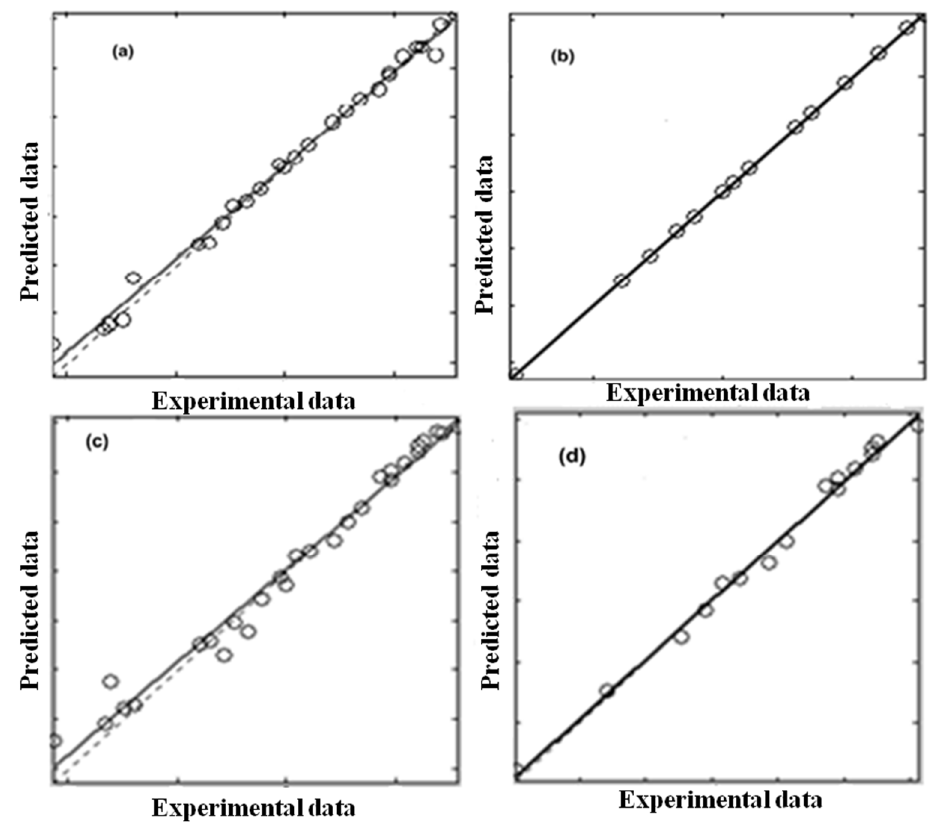
Figure 4. Experimental versus predicted data for ( a ) LM, ( b ) SCG, ( c ) BR, and ( d ) GDA algorithm.